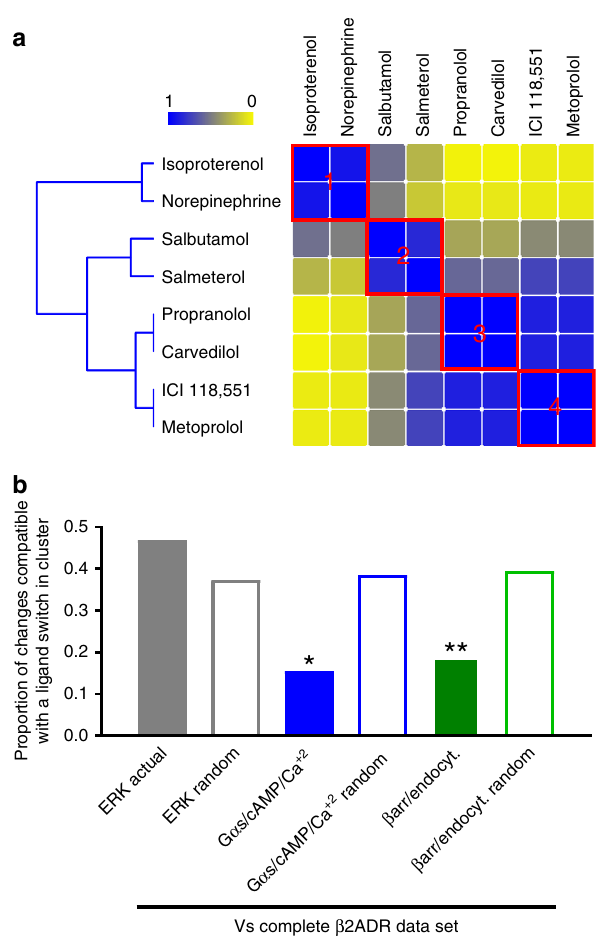
Fig. 6 β 2 ADR ligands cluster according to similarity in G protein and β arr- mediated responses. Ligand similarity heatmaps for h β 2 ADRs. Yellow and blue, respectively, indicate ligands/parameters that never or always cluster together. ( a ). Similarity matrices for partial data sets corresponding to ERK, G protein- (G α s, cAMP, Ca + 2 ), and β arr2- (recruitment, endocytosis) mediated responses were compared with the reference h β 2 ADRs data set. Filled bars: proportion of ligands changing clusters when comparing actual ERK, G protein, and β arr2 data sets to the reference; empty bars: proportions observed comparing the reference data set to corresponding simulations of random clustering for partial matrices. * p < 0.05, ** p < 0.01; z -score ERK: 1.523; z -score G protein: − 2.446 and z-score β arr: − 2.636 ( b ). Source data provided in Supplementary Data 10 and source data fi